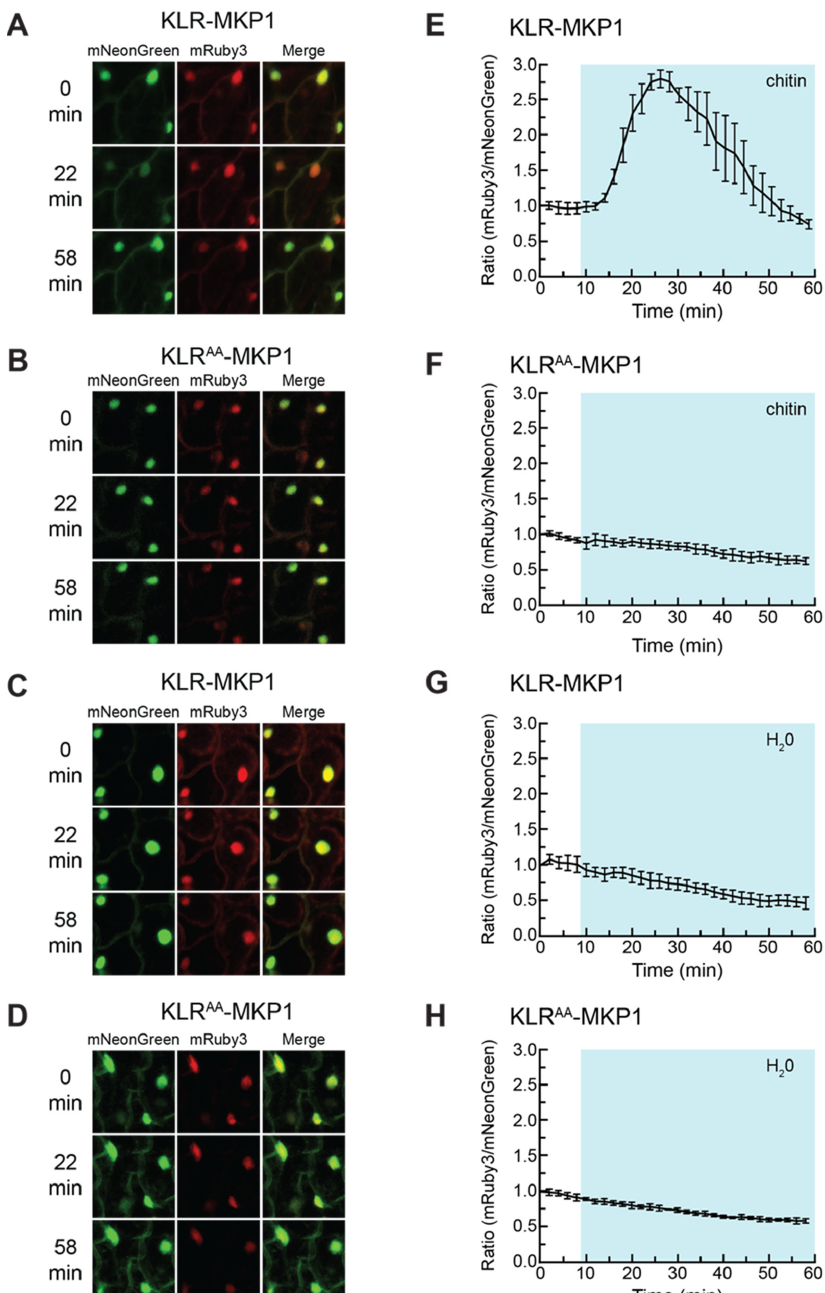
Figure 4. Chitin causes a transient reduction in nuclear mNeonGreen fluorescence of KLR-MKP1. ( A – D ) Arabidopsis cotyledons expressing KLR-MKP1 or KLR AA -MKP1 were treated with chitin ( A , B ) or water ( C , D ) and imaged every two minutes using confocal microscopy at 20× optical magnification. The mNeonGreen, mRuby3, and merged channels for the 0 min, 22 min, and 58 min time points are shown for each experiment. mNeonGreen emission is shown in green. mRuby3 emission is shown in red. ( E – H ) Quantification of the nuclear fluorescent emission for the experiments shown in ( A – D ). Each data point represents the ratio of the average mNeonGreen and mRuby3 emission intensities within four regions of interest (ROIs) corresponding to cell nuclei. The data were normalized by dividing each value in the time-course by the 0 min value. The shaded background on each graph indicates when the sample was exposed to a given treatment. During the first 10 min of each experiment the samples were incubated in pure water. Error bars indicate standard deviation. Videos are available as Movies